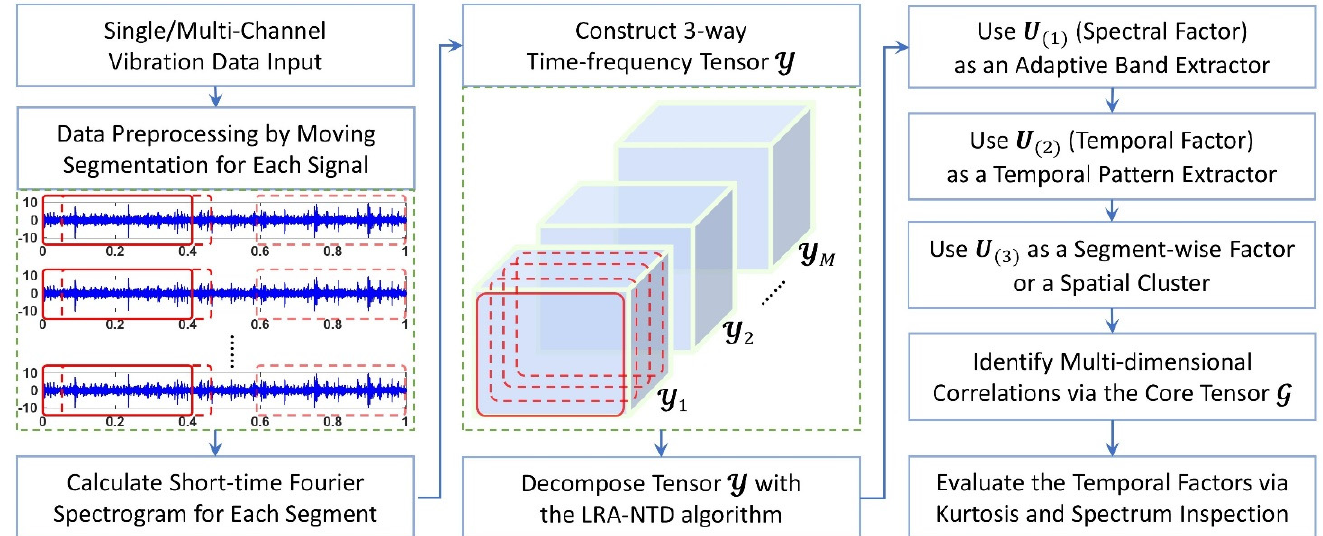
Figure 4. Flowchart of the diagnostic methodology.